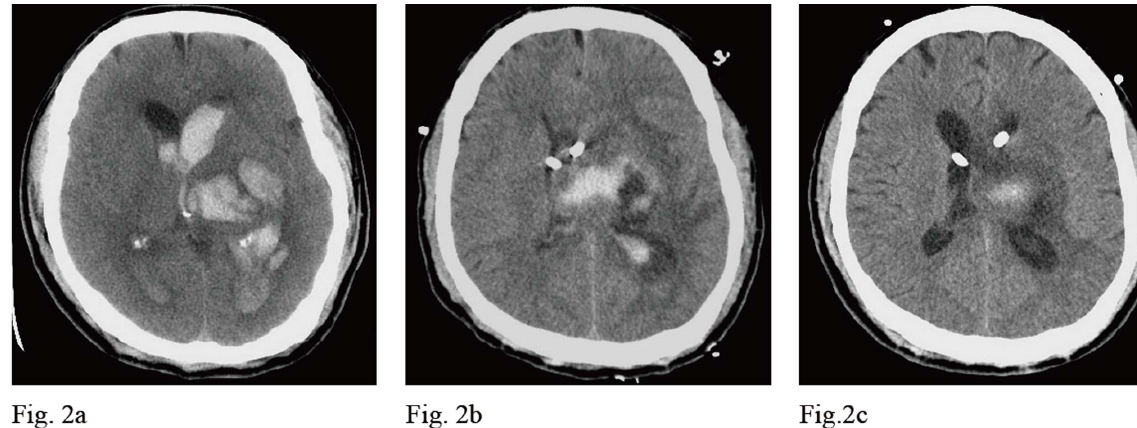
Fig 2. The change of brain CT scans in a spontaneous ICH patient (case 1) in 9 days. Fig 2a shows that the initial brain CT revealed left thalamic hemorrhage, intraventricular hemorrhage, and bilateral dilated ventricle. Fig 2b shows that on POD 6, the brain CT revealedthat left thalamic hemorrhage was stationary. The brain parenchyma was tight, especially on the left side. Severe peri-hematoma edema was noted and the brain was shifted to right side. Two EVD tubes were placed in the bilateral frontal horns and the ventricles became slim. Fig 2c shows that the follow-upbrain CT on POD 9 revealedthat the hematoma and perifocal edema regressedwith significantlyless mass effect. The brain parenchymabecame slack with clear margin of sulci. The EVD tubes were in bilateral enlargedlateral